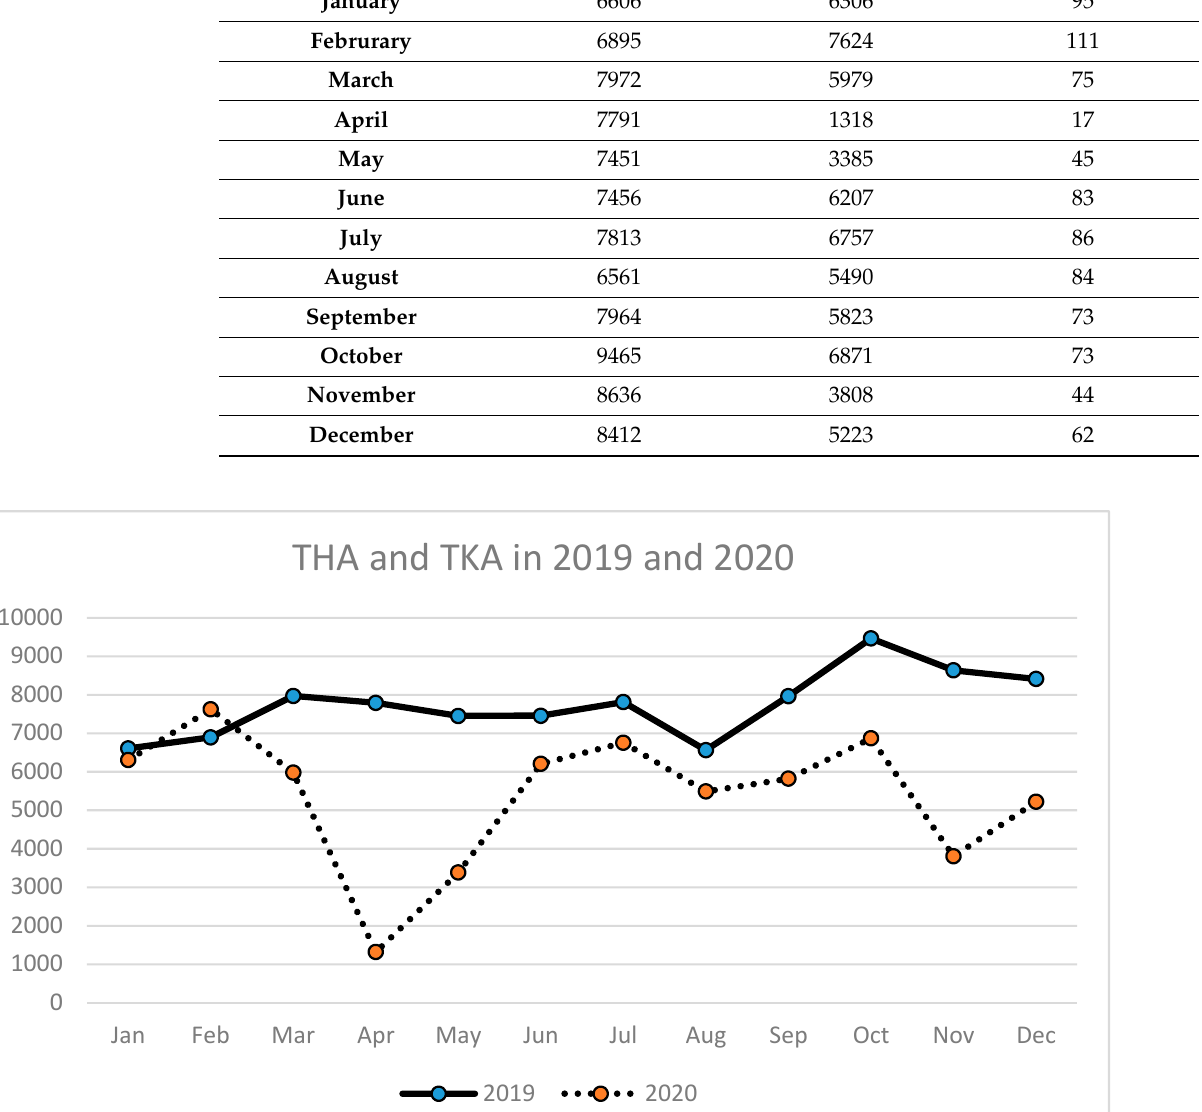
Table 3. Number of total hip arthroplasties (THA) performed in the particular months of 2019 and 2020 in Poland.